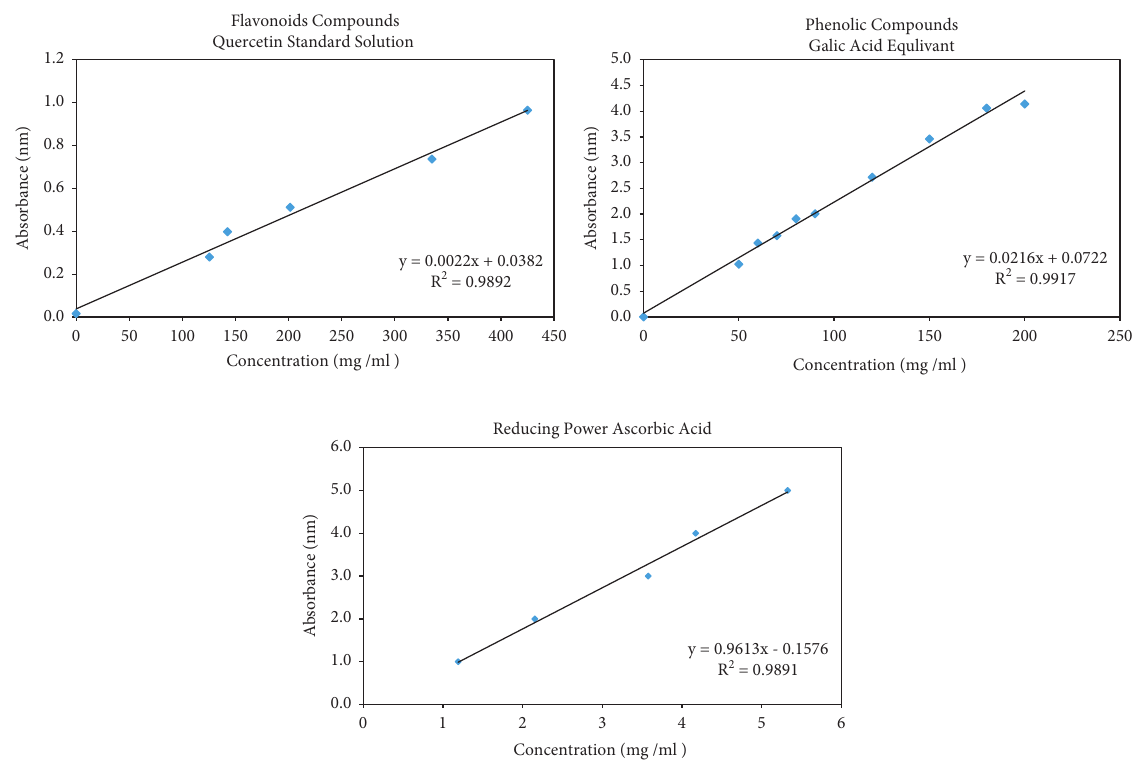
Figure 1: Standars curves used to calculate flavonoids, phenolic contents, and reducing power of dried, blanched, freezed, and fresh fruit by-